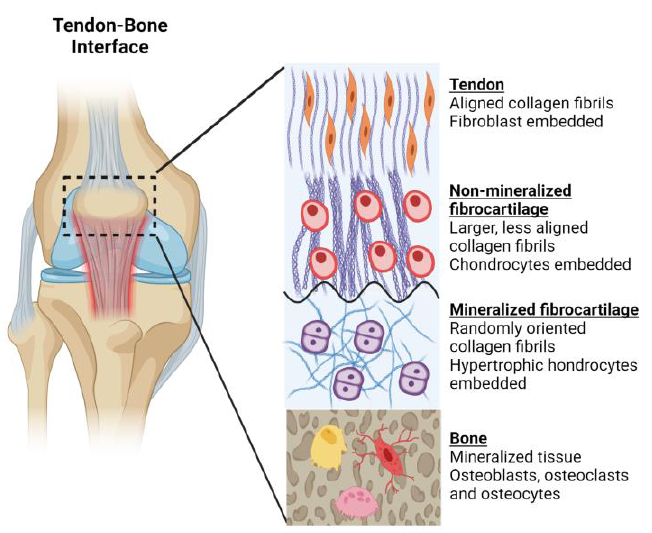
Figure 1. Tendon–bone interface showing the multicomponent and heterogeneous tissue structure. Adapted from Barajaa et al., 2020. Reused with permission from Springer Nature. Created with BioRender.com.